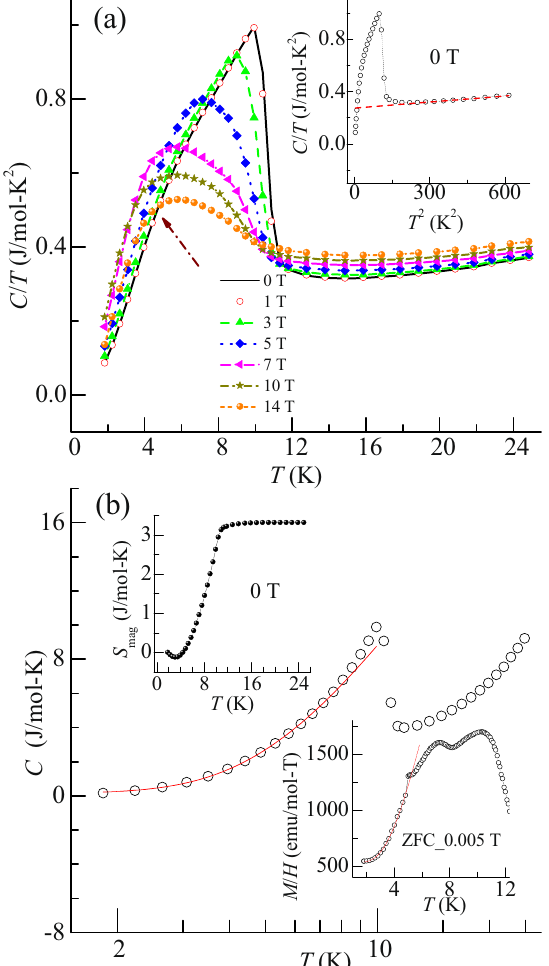
Figure 4. ( a ) Heat capacity divided by temperature ( C / T ) plotted as a function of temperature in field range of 0–14 T. Arrow shows the deviation in C / T near 7.6 K at 0 T. Inset: T 2 dependent C / T at 0 T. Red curve shows the linear fitting above the ordering temperature, which is extrapolated to the lowest temperature. ( b ) Temperature (logarithmic scale) dependent heat capacity at 0 T. Red curve shows the curve fitting of equation (3). Upper inset: Temperature dependent magnetic entropy ( S mag ) at 0 T. Lower inset: Temperature dependent M / H at 0.005 T (ZFC mode). Red curve shows the fitting of equation